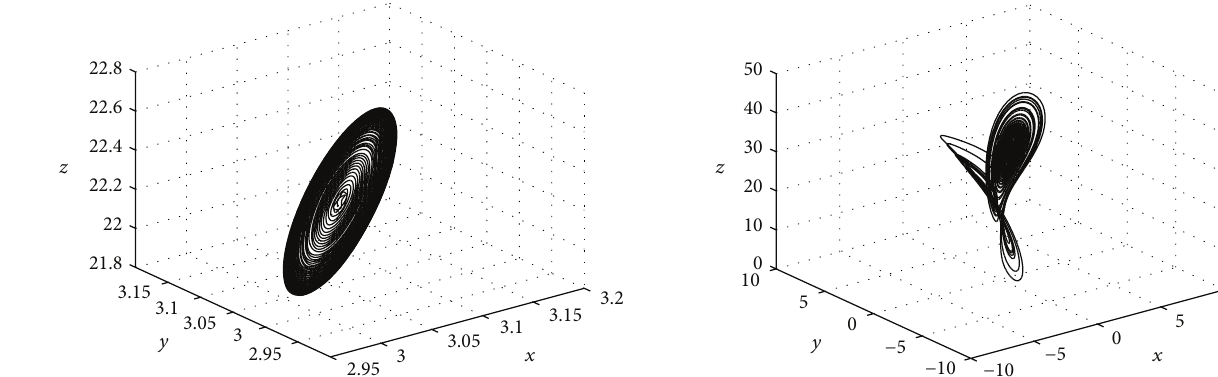
Figure 6: The steady state 𝑆 + of system (4) is unstable when 𝑏 1 > 𝑏 𝑐 .